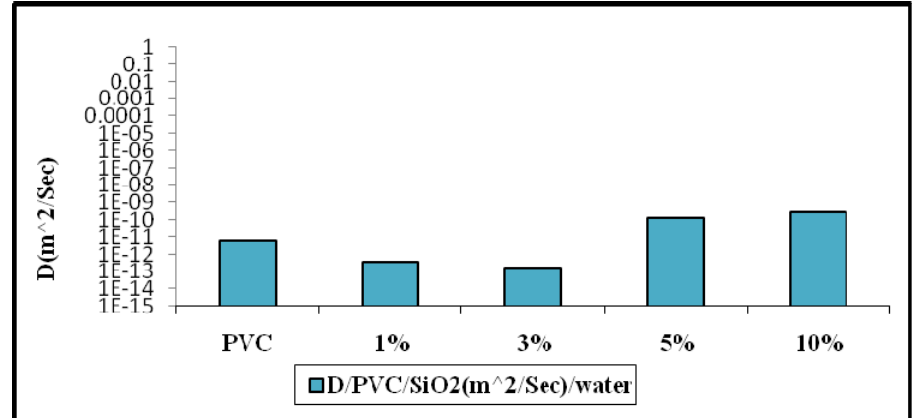
Fig.9: Diffusion coefficient values versus wt. % of SiO